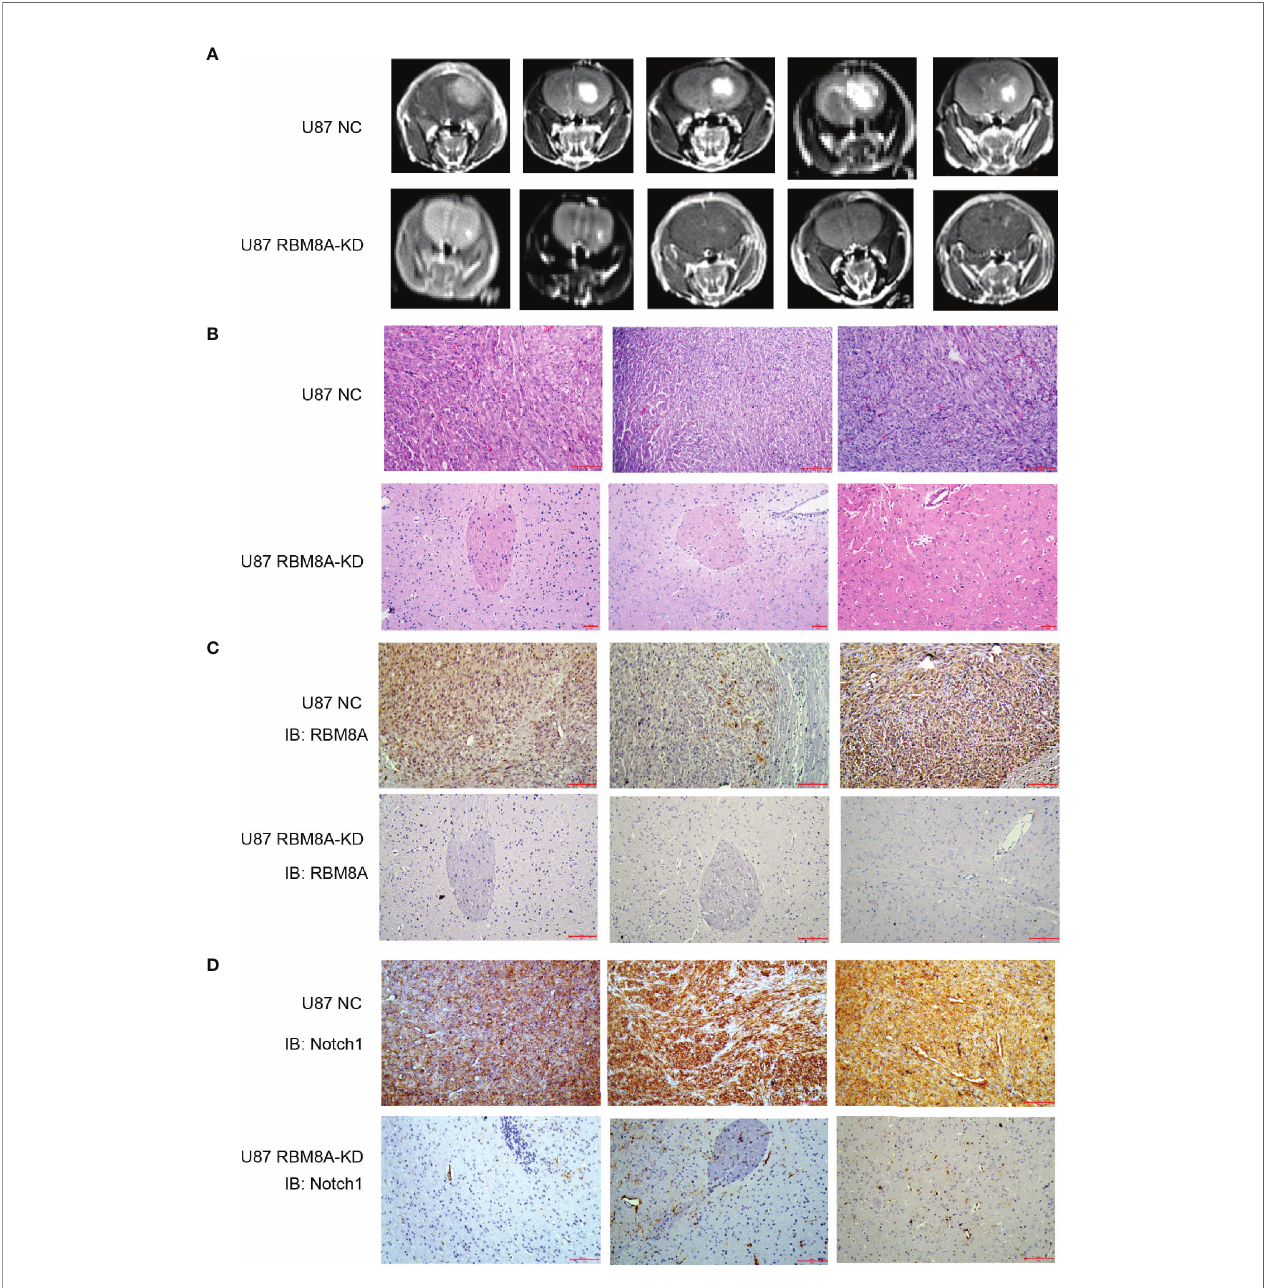
FIGURE 6 | Effects of RBM8A reduction on GBM progression in vivo. (A) Nude mice were intracranially injected with U87-MG cells transformed with empty lentivirus (NC) or lentivirus encoding short hairpin RBM8A-KD1. At 6 weeks after injection, animals were examined by MRI. (B) Representative photomicrographs of tumor sections stained with hematoxylin-eosin (H&E). (C) Immunohistochemistry of tumor tissues stained with antibody against RBM8A. (D) Immunohistochemistry of tumor tissues stained with antibody against